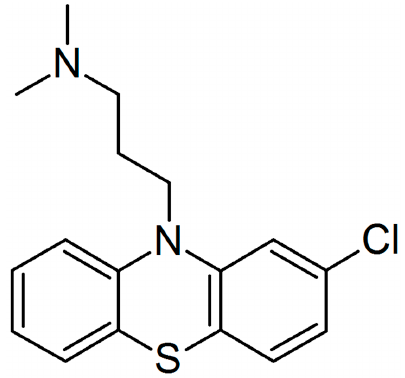
Figure 1. Structure of chlorpromazine.